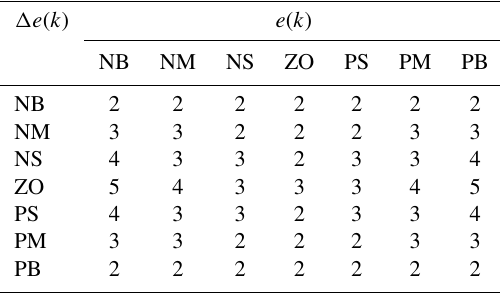
Table 3. Fuzzy Tuning Table for Constant alpha .